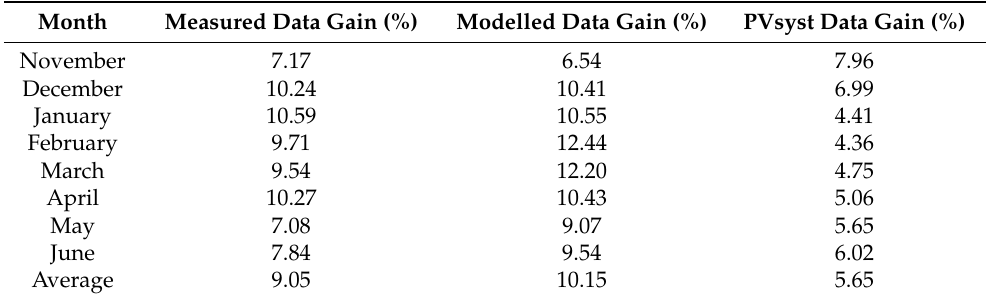
Figure 7. Monthly bifacial gain over inclined monofacial PV system. Table 7. Monthly inclined bifacial system energy gain over inclined monofacial